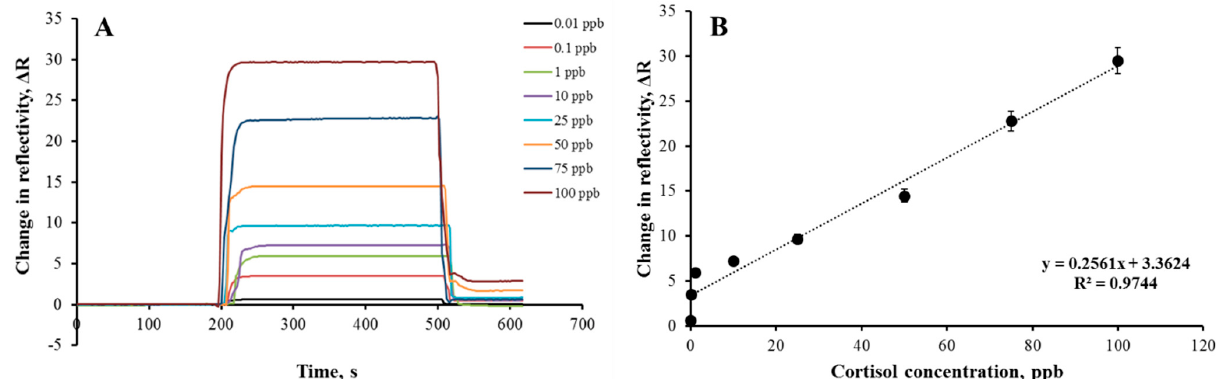
Figure 4. Real-time sensorgrams ( A ) and calibration graph ( B ) of AuNP-MIP plasmonic sensor at different concentrations of cortisol samples. Cortisol concentration: 0.01–100 ppb; adsorption solution: PBS-ethyl alcohol (50:50, v / v ); interaction time: 10 min; flow rate: 0.2 mL/min; T: 25 °C.